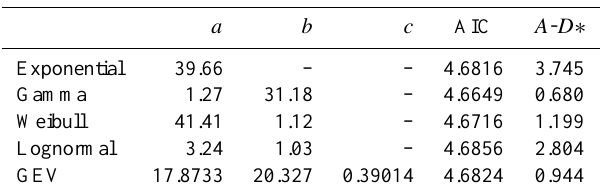
Table 9. Marginal distribution parameters and goodness of fit re- sults for flood volumes ( V ) .